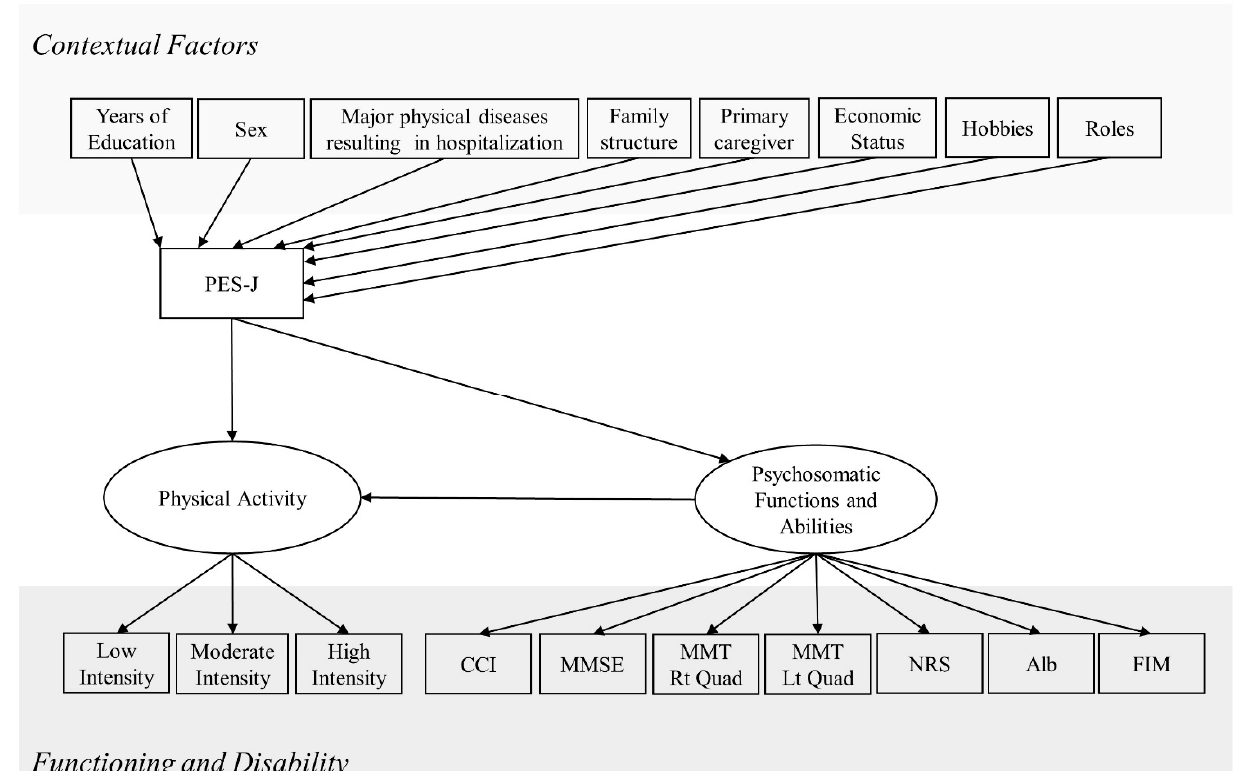
Figure 1. Empowerment structure model based on the hypothesis. CCI: Charlson Comorbidity Index, MMSE: Mini-Mental State Examination, MMT: manual muscle testing, NRS: Numerical Rating Scale, Alb: serum albumin test, FIM: functional independence measure, PES-J: Patient Empowerment Scale—Japanese Version.